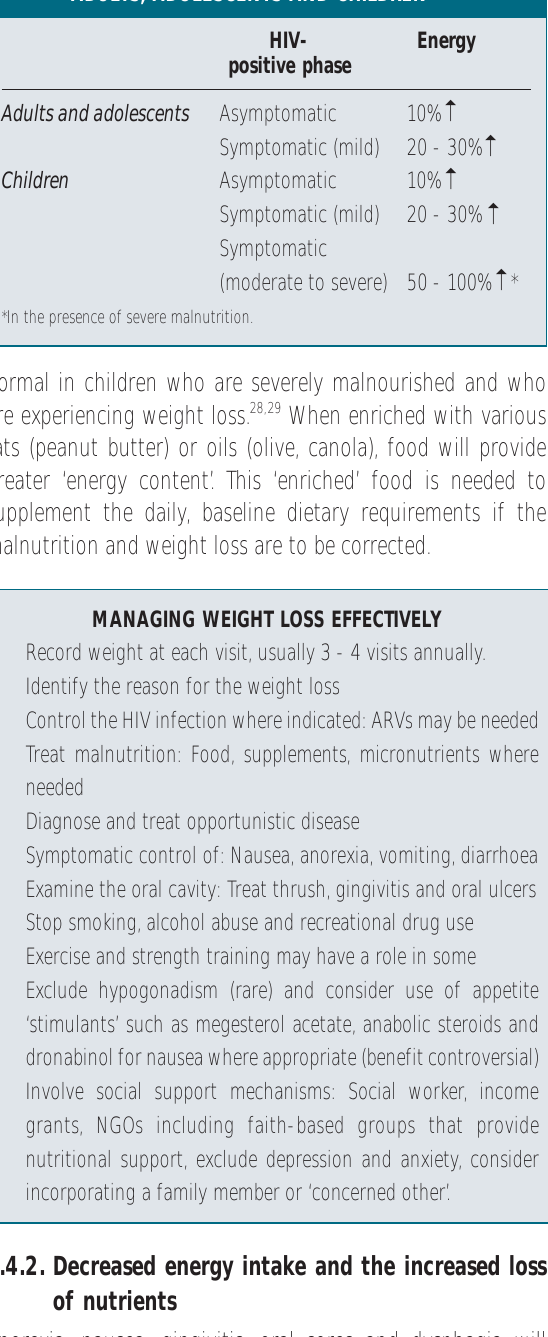
TABLE 1.1. INCREASED ENERGY NEEDS OF HIV-INFECTED ADULTS, ADOLESCENTS AND CHILDREN